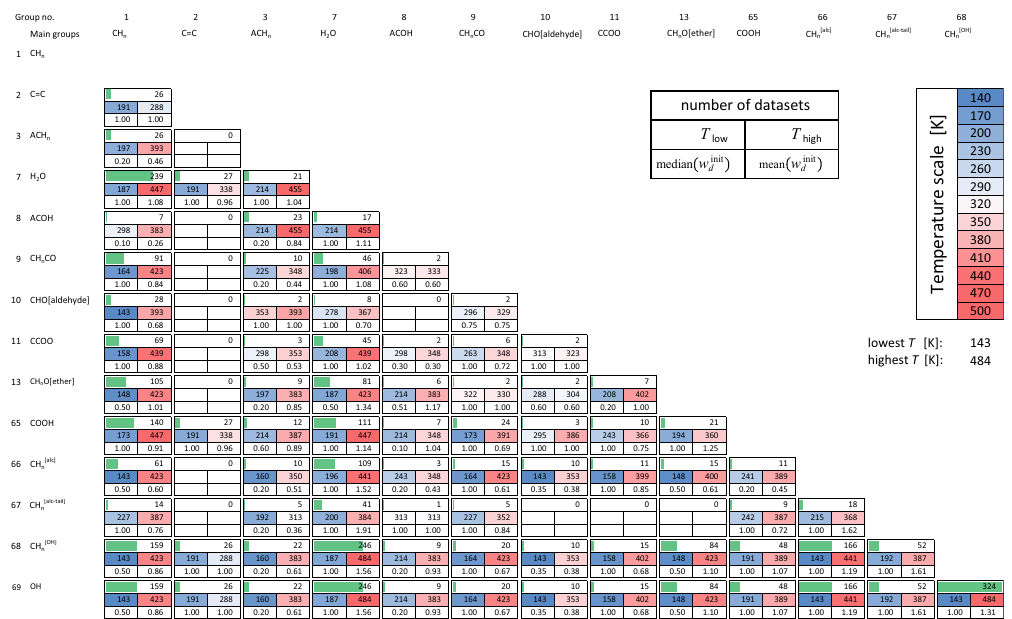
Figure 1. Database distribution for the water ↔ organic and organic ↔ organic interaction parameters. The table lists for each main group interaction pair at temperatures substantially different from the reference temperature, T (cid:9) = 298 . 15K, i.e. per data set d : T d, low < 289K or T d, high > 307K, the following information. Top boxes: the total number of data sets available, visualised by the green bars. Middle boxes: the lowest temperature ( T low ) and the highest temperature ( T high ) (units of K) of the data points using a percentile-wise colour scale. Bottom boxes: the median and arithmetic mean of the assigned initial data set weighting values ( w init ) of the data sets involved. d